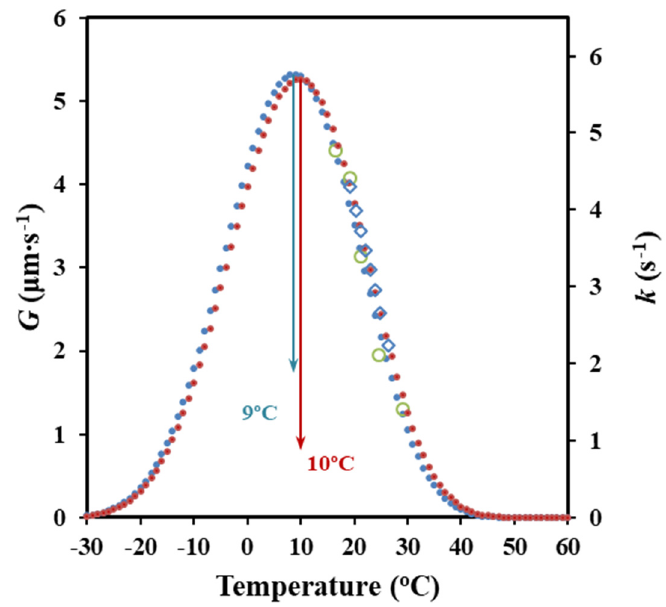
Figure 10. Comparison between bell-shaped curves of G / k temperature dependence obtained from DSC data and the two non-isothermal methodologies (from Avrami analysis ( ● ) and activation energy ( ● ) with their respective experimental results ( о ) ( ◊ ). An arbitrary value of G 0 has been selected to fit the maximum rate of both curves.